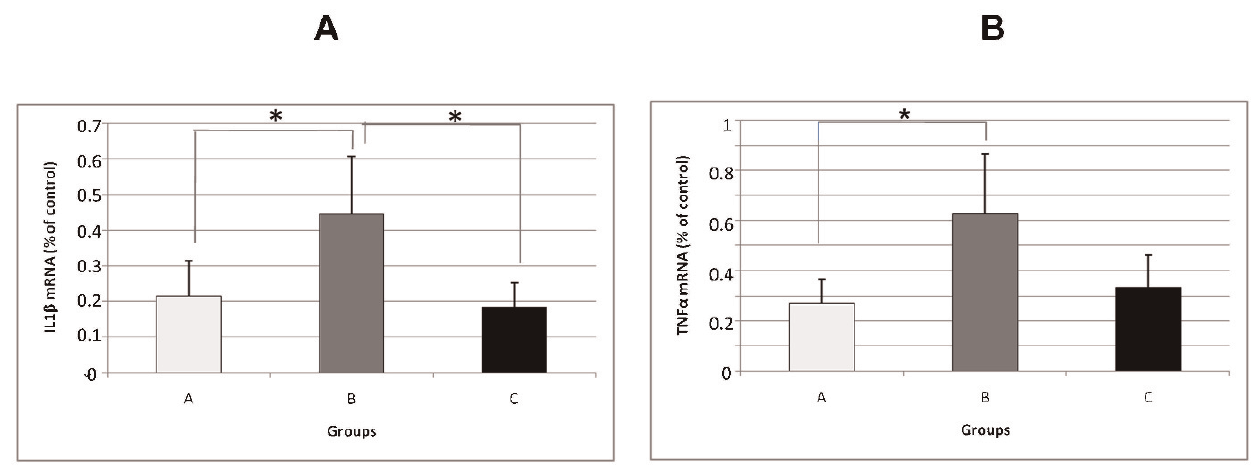
Figure 5 - mRNA expression levels of IL1 b (A) and TNF a (B) in the hippocampus of rats in the pilocarpine model of epilepsy as evaluated with a real-time PCR assay. All data have been normalized for the levels of GAPDH expression. Data are given as the mean ¡ S.E.M. (n=5 per group). * p ,